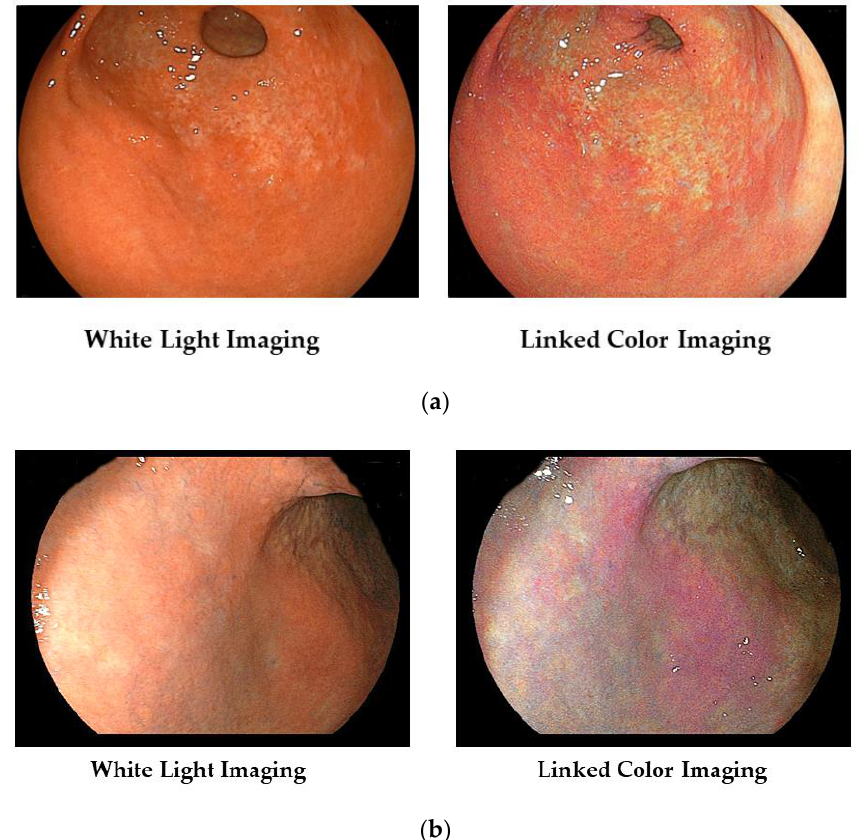
Figure 2. ( a ) Typical images of the FP-border (atrophic border) in a patient with chronic active gastritis. ( b ) Typical images of the H. pylori -associated active gastritis with WLI and